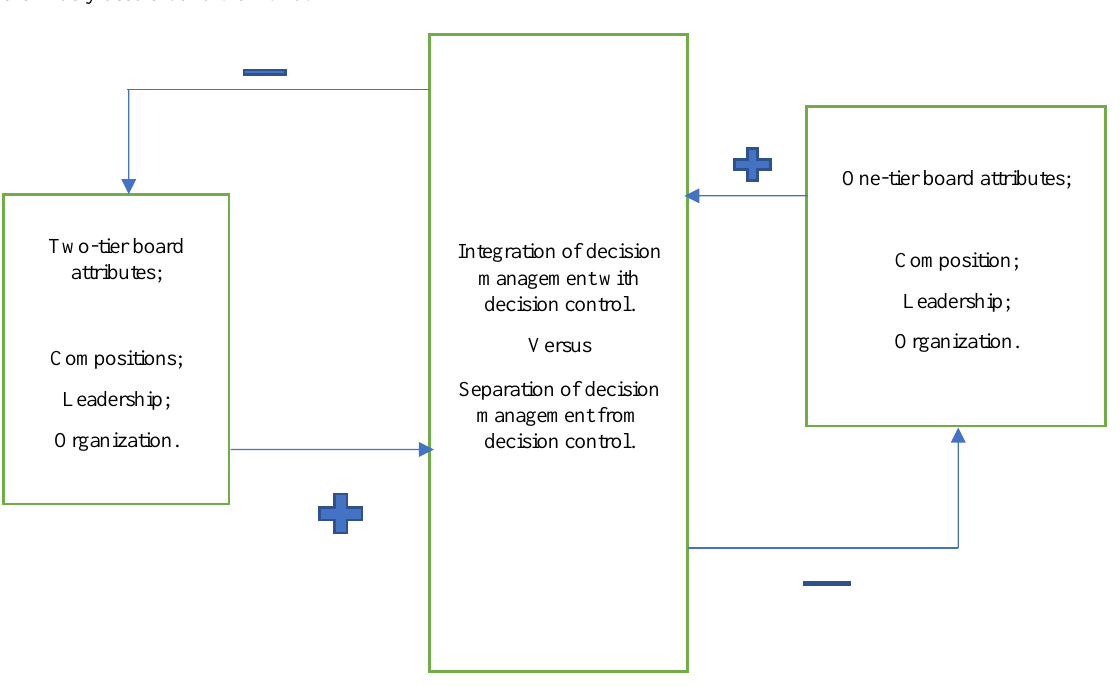
Figure 1: The Formal Board Models; Source: Yasser et al.,